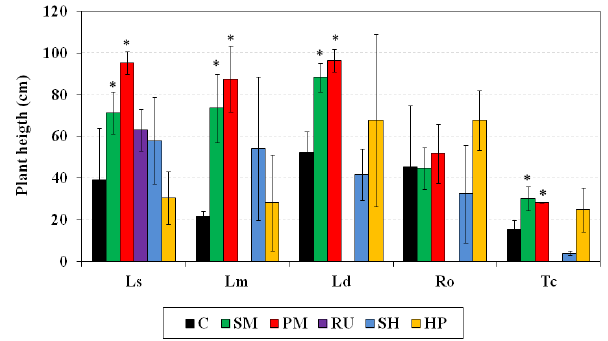
Figure 3. Plant height from ground to terminal bud of the tallest stem (in centimeters) 30 months following transplantation (May 2014). C: soil afforested and not amended; SM: straw mulch; PM: